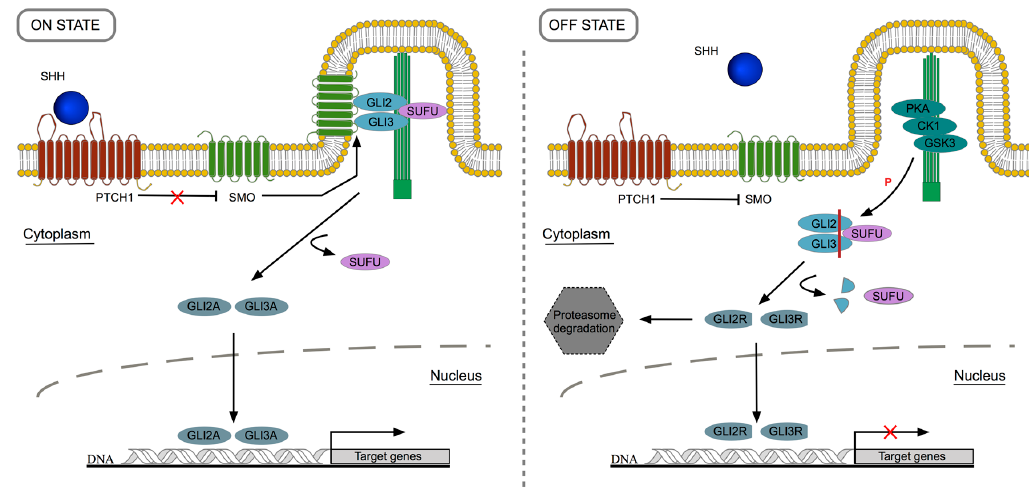
Figure 1. Sonic hedgehog signaling pathway. (1) ON state: SHH protein binds to PTCH1 receptor, at the cell surface level. This event abolishes SMO inhibition that can move to the primary cilia to induce GLI activation through SUFU detachment. Then, GLI2A and GLI3A translocate to the nucleus in order to promote the transcription of target genes; GLI2A acts as the main activator. (2) OFF state: In the absence of SHH ligand, PTCH1 inhibits SMO, and GLIs are phosphorylated by PKA/CK1/GSK3 complex. GLI2R and GLI3R are formed and can follow two possible destinations: proteasome degradation or translocation into the nucleus to repress the transcription of targets genes. In this case, GLI3R is the major repressor.